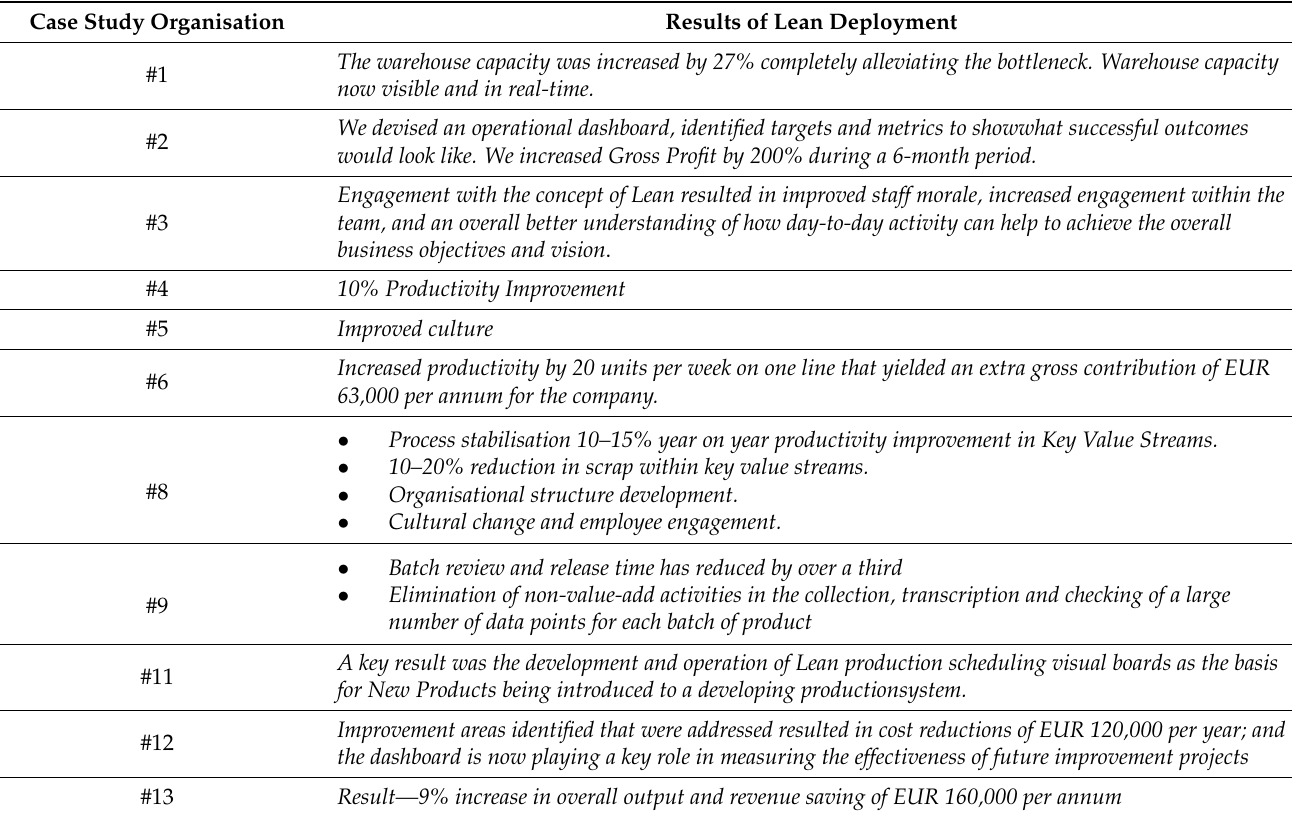
Table 5. Results of Lean Deployments in Irish MedTech case study organisations. Case Study Organisation Results of Lean